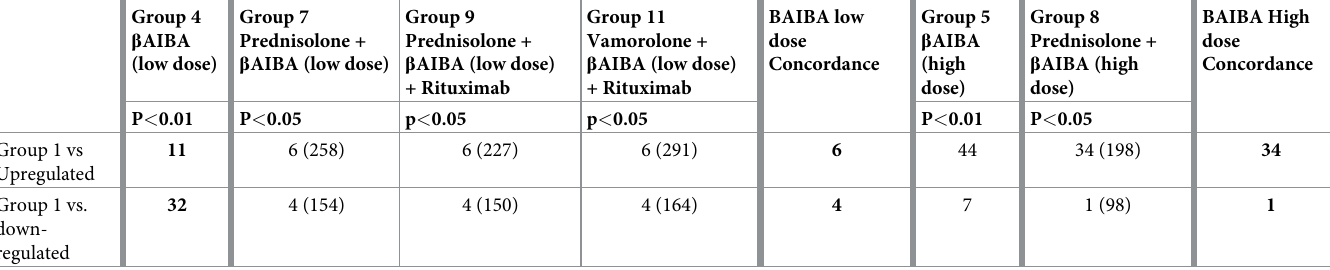
Table 7. Serum proteomics comparisons of drug-treated vs. non-treated controls (Group 1) for BAIBA-treated mdx mice. Group